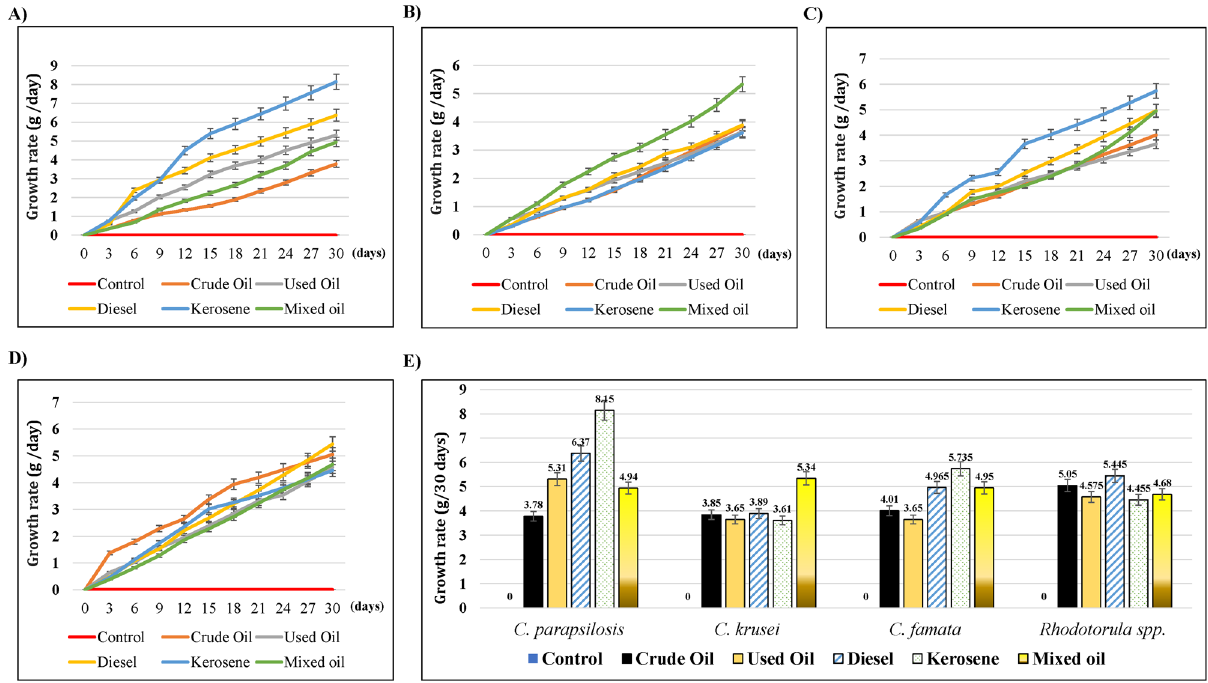
Figure 1. Effect of different Hydrocarbons on the growth rate of soil-isolated strains. The yeast strains were grown on MSM liquid medium mixed with 1% of either crude oil, used oil, diesel, kerosene, or mixed oil. The growth was observed for 30 days. The statistical analysis of differences in growth rates of the isolated strains was performed using SPSS statistical package (version22) for the One-way ANOVA and Dunnett’s, where the values were significant P < 0.05 . ( A ) C. parapsilosis , ( B ) C. krusei, ( C ) C. famata, and ( D ) Rhodotorula spp. ( E ) Bar chart of the growth rate of all the isolated strains, 30 days post-incubation with different